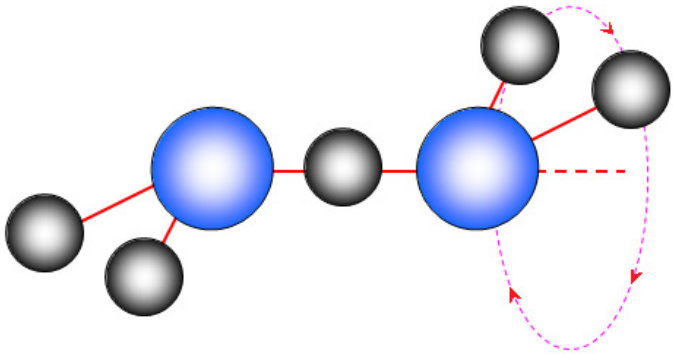
Figure 4. Scheme of the –OH 2 fragment rotation of the H + (H 2 O) n ion relative to the strongest hydrogen bond.